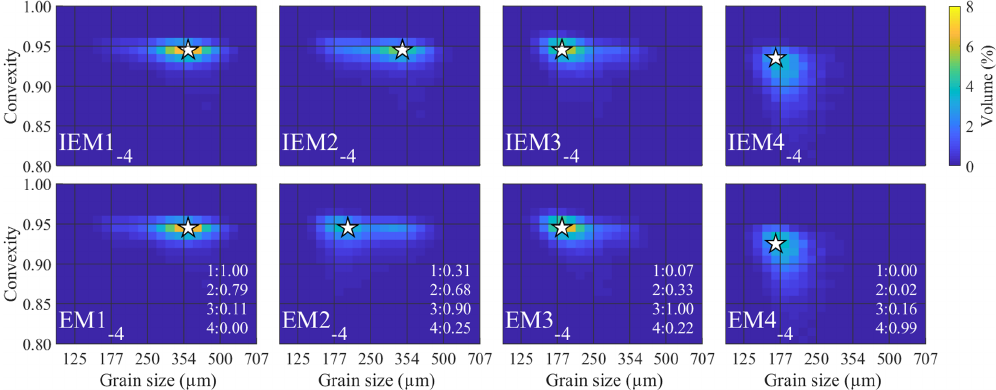
Figure 8. Endmembers determined for the ConD2d 4EM_noise_ highmix dataset. Input endmembers (top) are compared to determined endmembers (bottom) including R 2 values. The first R 2 value indicates the correlation of the determined endmember with IEM1 − 4 , the second with IEM2 − 4 , etc. White stars mark the modes of the